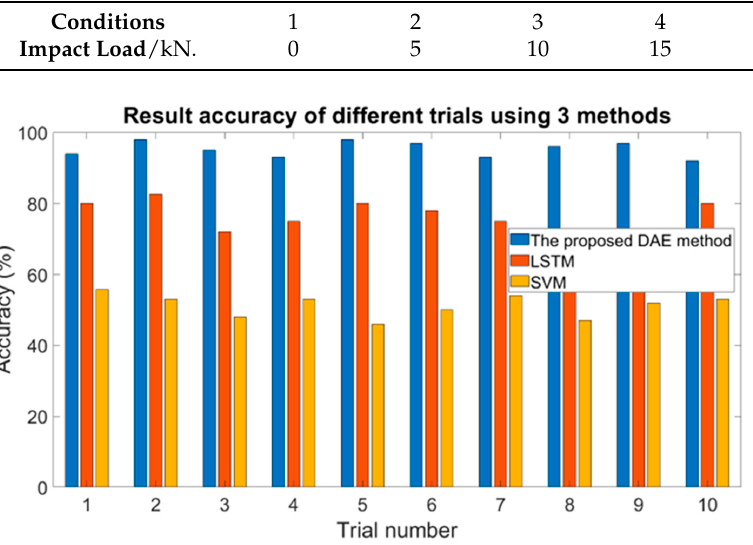
Figure 4. Diagnosis results of 10 trials using three methods.